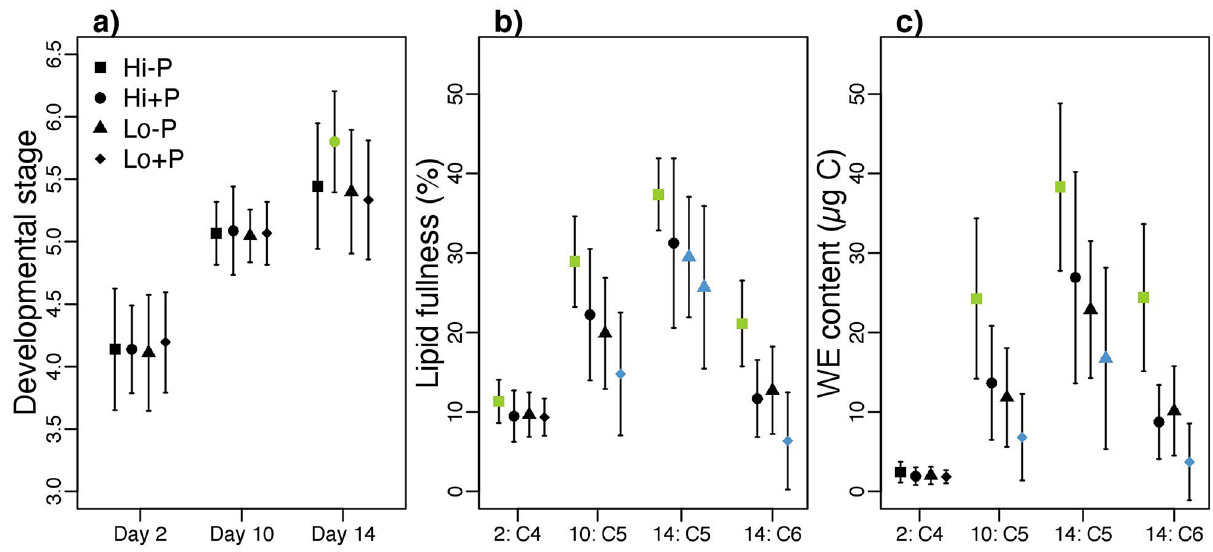
Figure 7. Development stage ( a ), lipid fullness (%) ( b ) and estimated wax ester (WE) content (μg C) ( c ) in Calanus finmarchicus copepods exposed to a combination of presence or absence of a predator cue and high or low food availability. Each treatment (see icons in legend) had three replicate tanks, each of which were sampled on each sampling day. Development stage was calculated by setting C4 = 4, C5 = 5 and C6 = 6. Symbols and vertical lines: mean values ± standard deviation (SD) per day and stage (for panels b , c ). Within each day and stage (for panels b , c ), green symbols denote significantly higher estimates (P < 0.05) relative to blue symbols between treatments. Hi-P High food and no predator cue, Hi + P High food and predator cue, Lo-P Low food and no predator cue, Lo + P Low food and predator